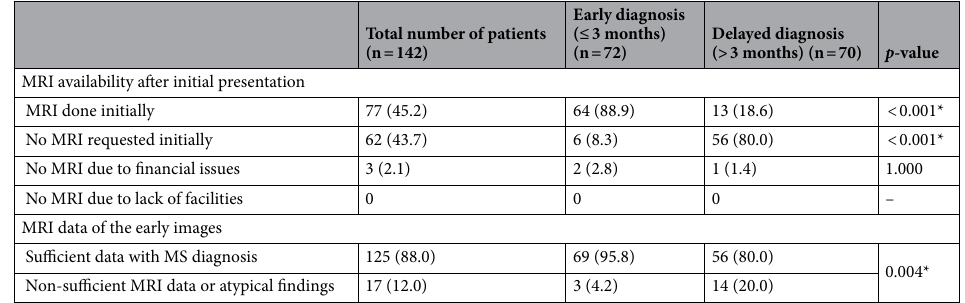
Table 4. MRI data at initial presentation. p , p -value for comparing between the studied categories. *Statistically significant at p ≤ 0.05.